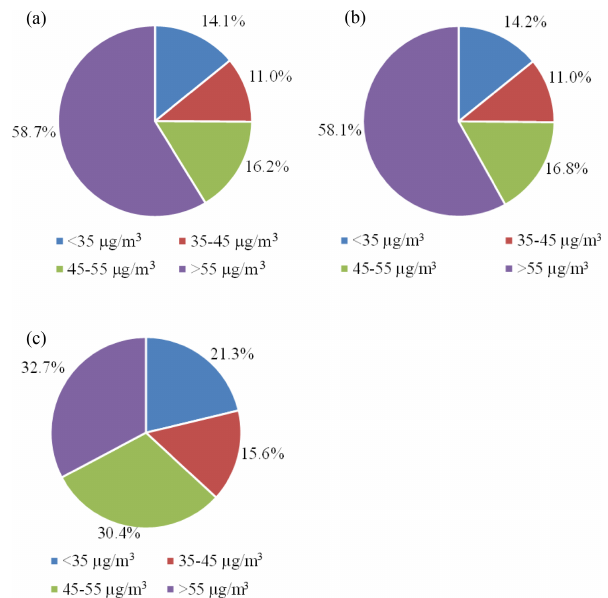
Figure 6. The population fractions exposed to different levels of PM 2 . 5 in the YRD region for cases 2 (a) , 3 (b) , and 4 (c)